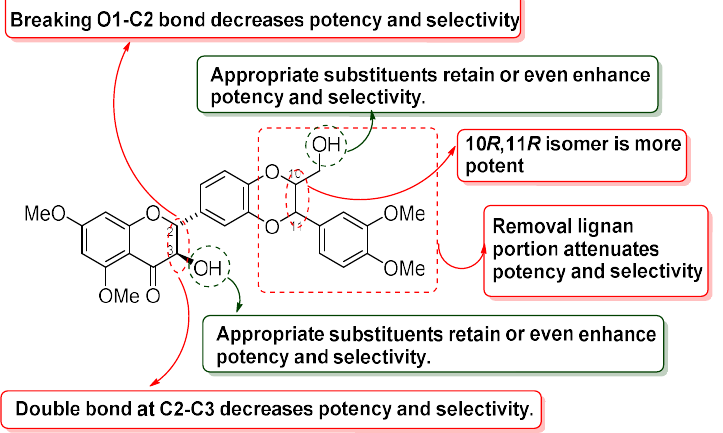
Figure 10. Structure-Activity Relationships of 5,7,20- O